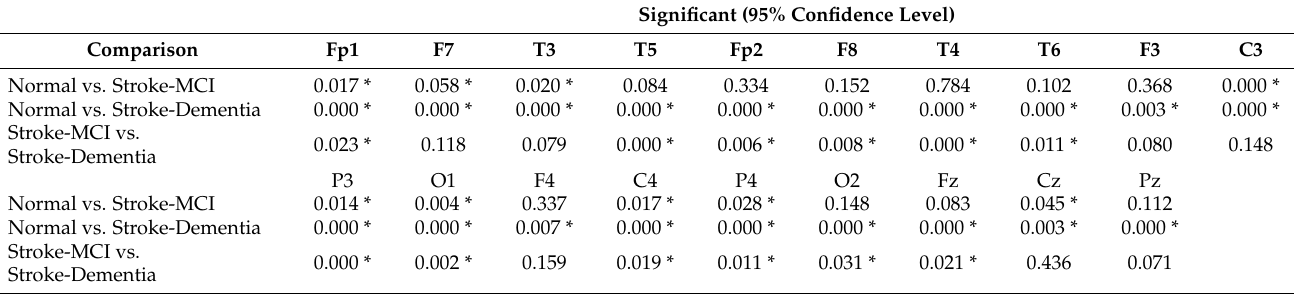
Table 10. The results of post hoc multiple comparison